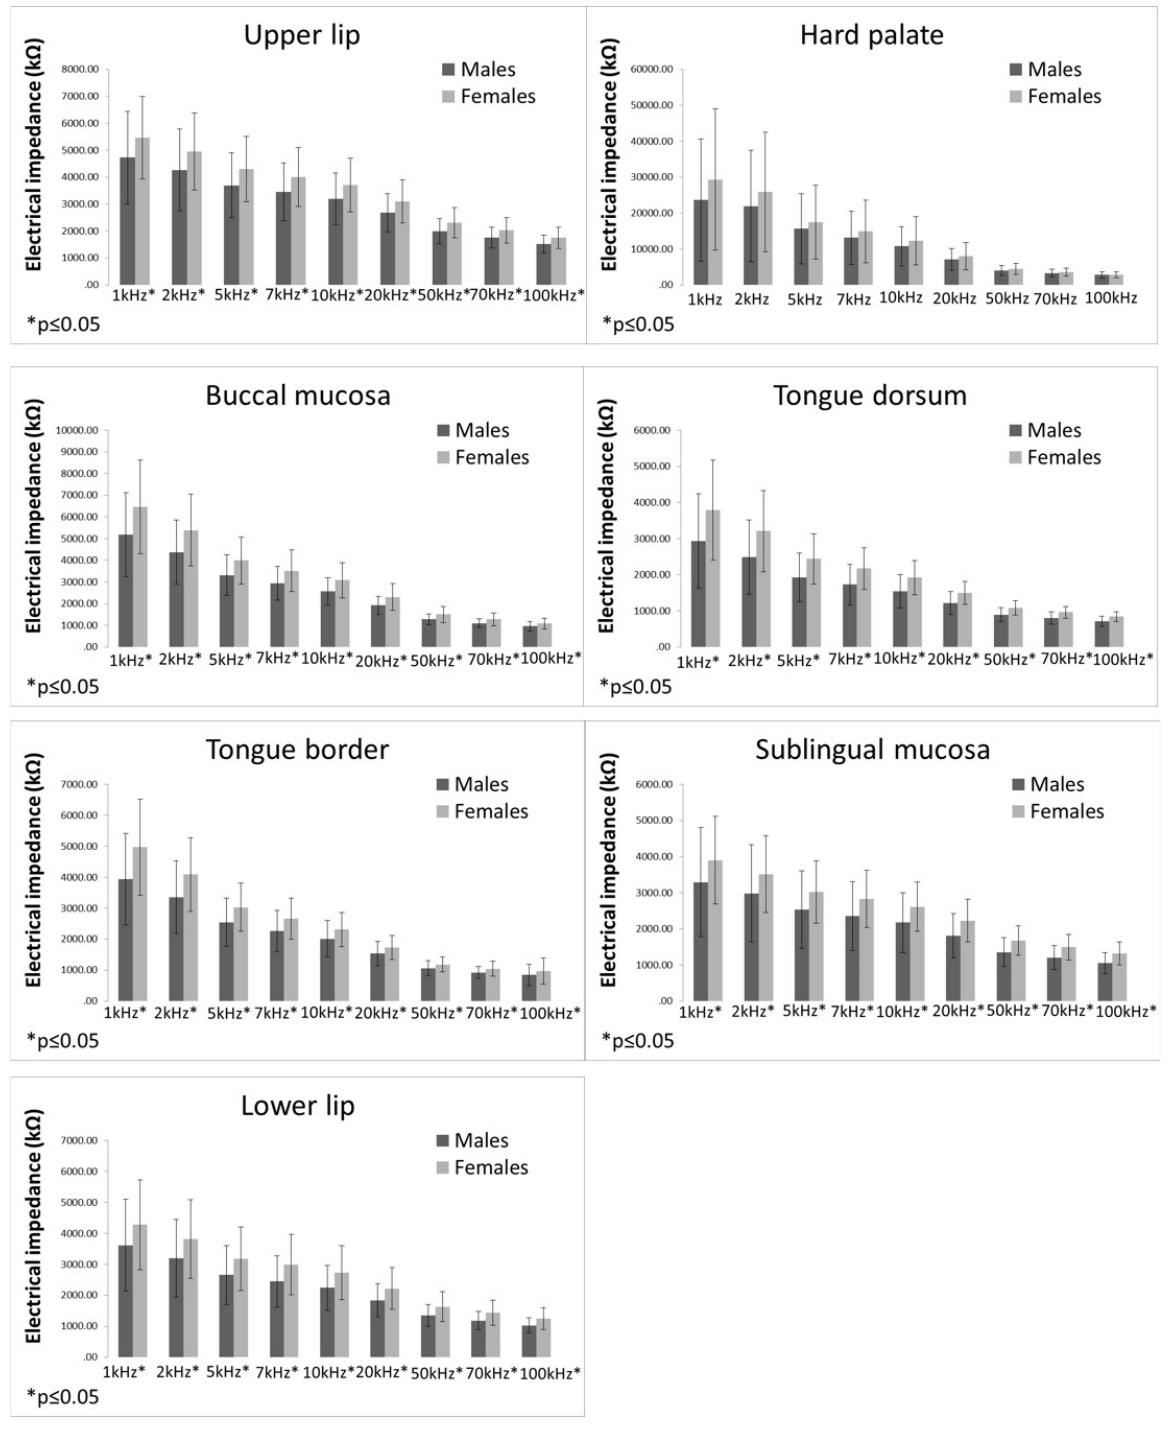
Figure 3. Electrical impedance measurements in males and females (bars representing mean ± standard deviation).